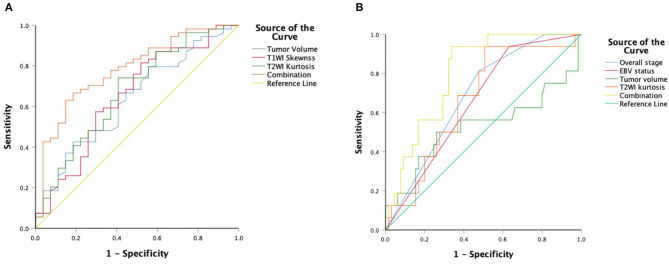
An ROC curve to differentiate the EBV DNA-negative group compared with the EBVDNA-positive group using T1WISkewness, T2WIKurtosis, tumor volumes, and a combination of the three variables (A). An ROC curve to differentiate the PD from the non-PD group using overall stages, tumor volumes, T2WIKurtosis, and EBV statuses and a combination of the four variables (B). ROC, receiver operating characteristic; T1WI, T1-weighted imaging; EBV, Epstein–Barr virus; T2WI, T2-weighted imaging; PD, disease progression.